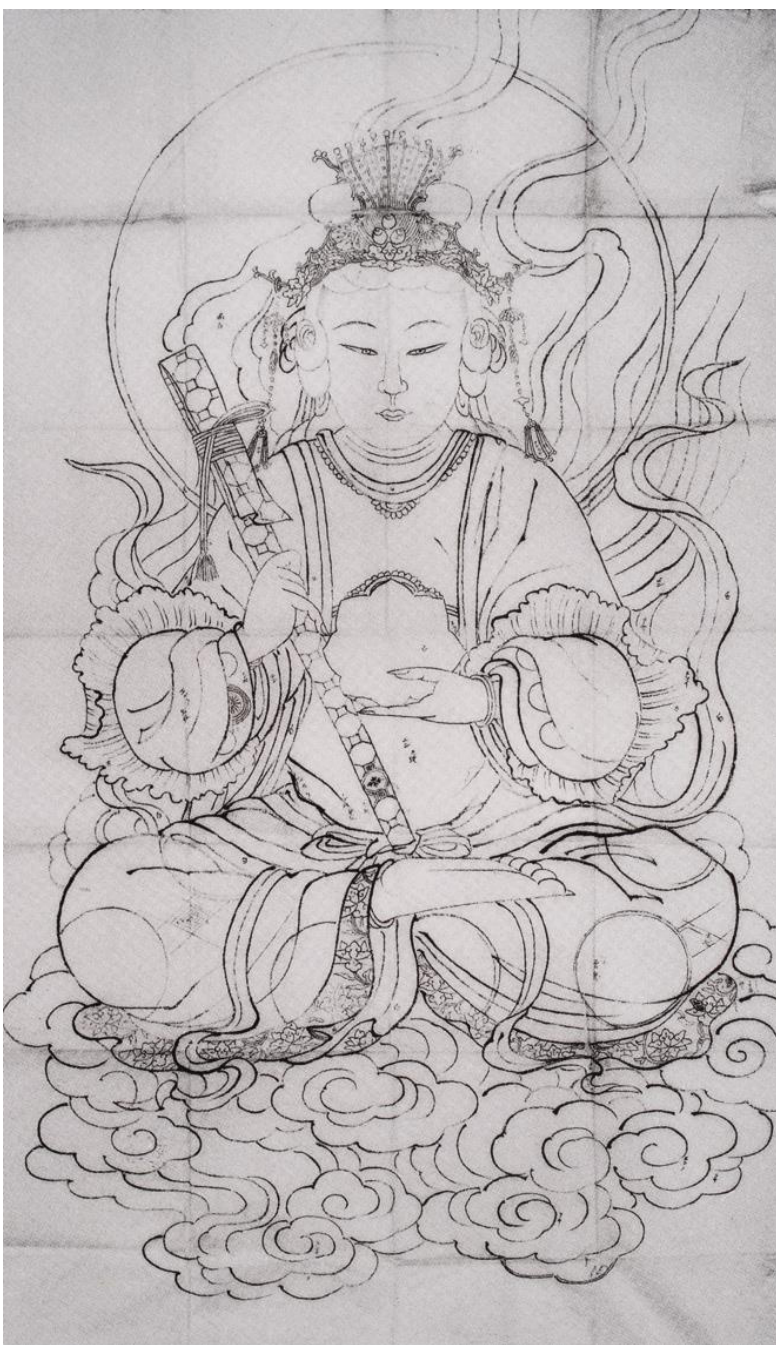
Figure 9. Amaterasu (Tenshō Daijin), Edo period, woodblock print, ink on paper. University Art Museum, Kyoto City University of Arts. Reproduced with permission from Faure (2016). Copyright 2016 University of Hawai‘i Press.